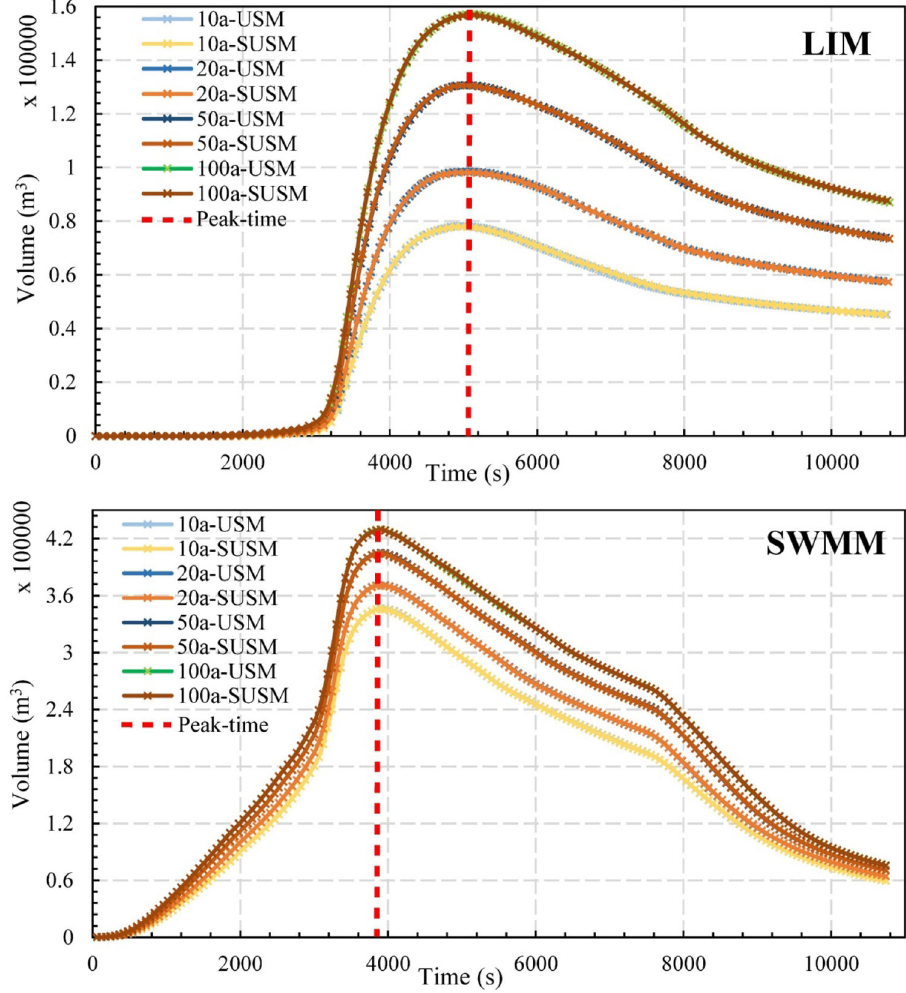
Fig. 8 Water volume hydrographs of the local inertial approximation form model (LIM) and Storm Water Management Model (SWMM) in the four rainfall return periods. USM = urban stormwater model; SUSM = simplified urban stormwater